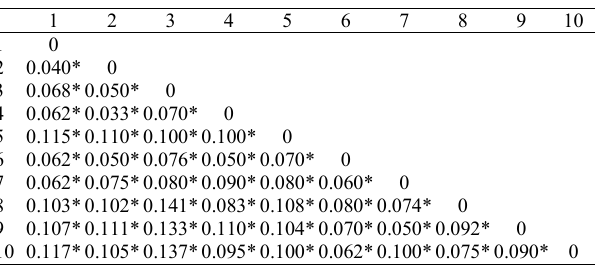
Table 4. F pair to pair, based on RAPD markers, between ST groups of Leporinus elongatus from the fish passage ladders of HEPs Canoas I (1 - 6) and Canoas II (7 - 10) - Paranapanema River. * Statistically significant value to 5%.